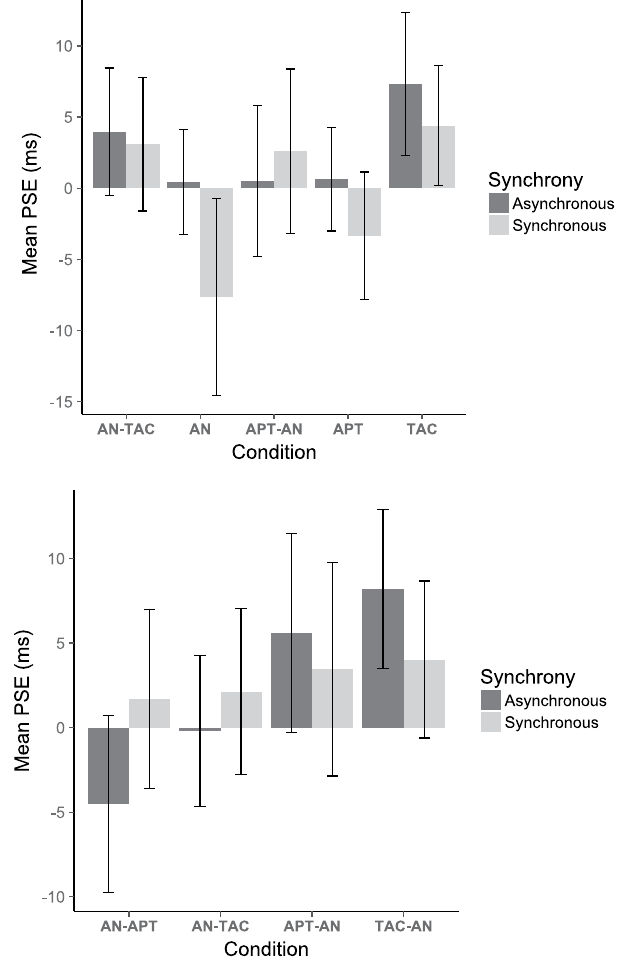
Figure 6. Averaged PSEs across 20 participants, according to the cross-modal flanker condition, for all data (top) and directional data (bottom; see Fig. 5 for condition names) based on whether the cross-modal flankers occurred synchronously with the visual onsets, or led the first and lagged the second visual onset by 100 ms. Error bars are